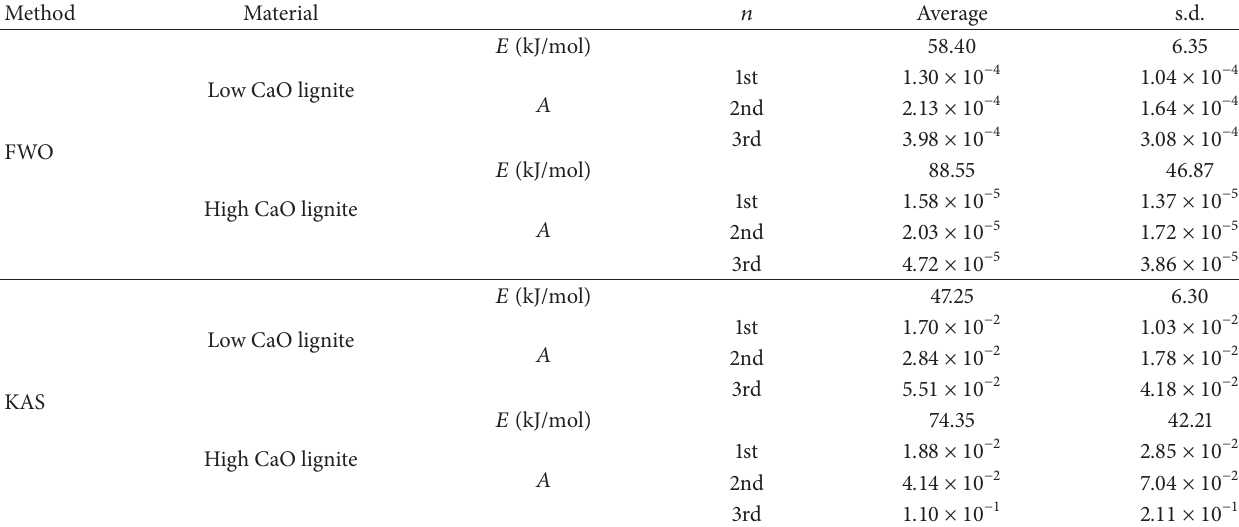
Table 2: Calculated combustion kinetic